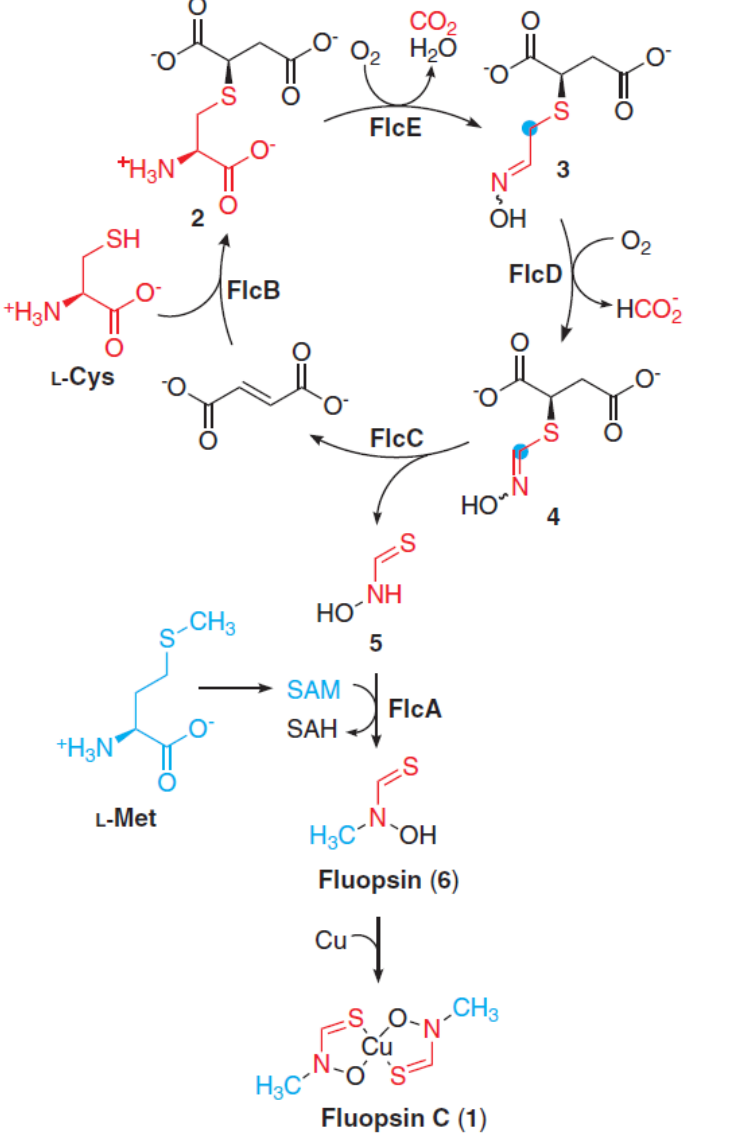
Figure 3. Fluopsin C biosynthetic pathway model highlighting the reactions catalyzed by the Flc enzymes. Reprinted with permission from AAAS. Copyright 2021 from ref. [34]. The structural contribution of L − Cys and L − Met are highlighted by the colors red and blue, respectively.